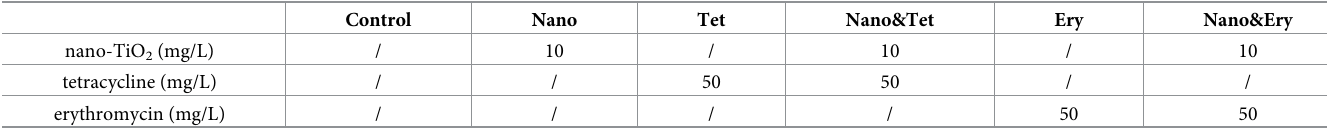
Table 1. The concentration of Nano-TiO 2 and antibiotics in the influents of each reactor. Control Nano Tet Nano&Tet Ery